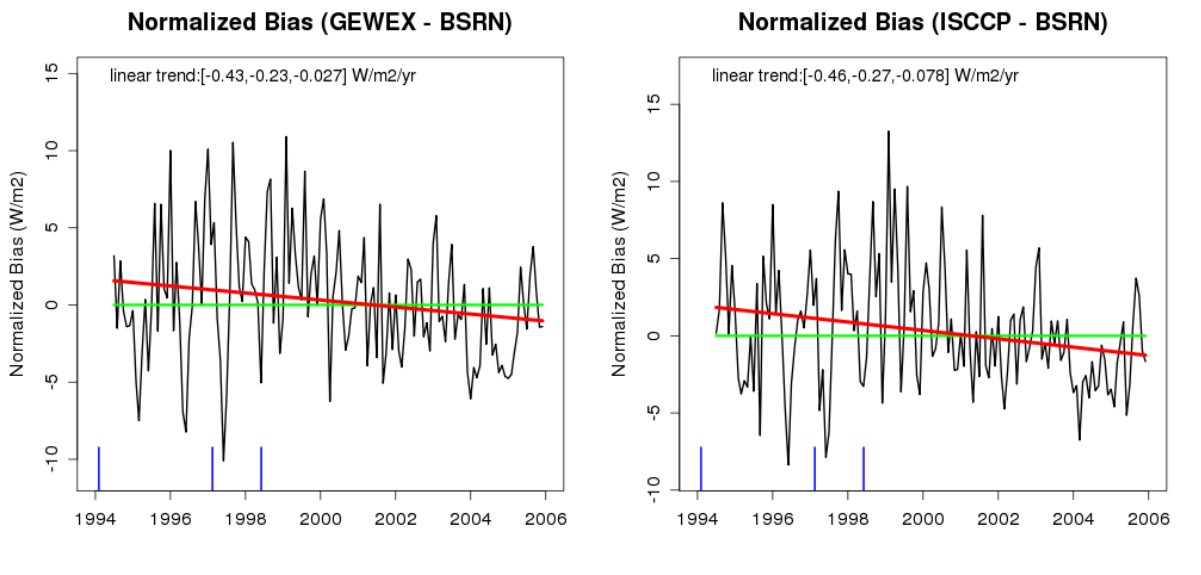
Figure 6. Temporal evolution of the normalised differences between the GEWEX and ISCCP data set relative to the BSRN data including the trend colored in red. Significant trend are apparent for both data sets indicating serious problems in the homogeneity of the data